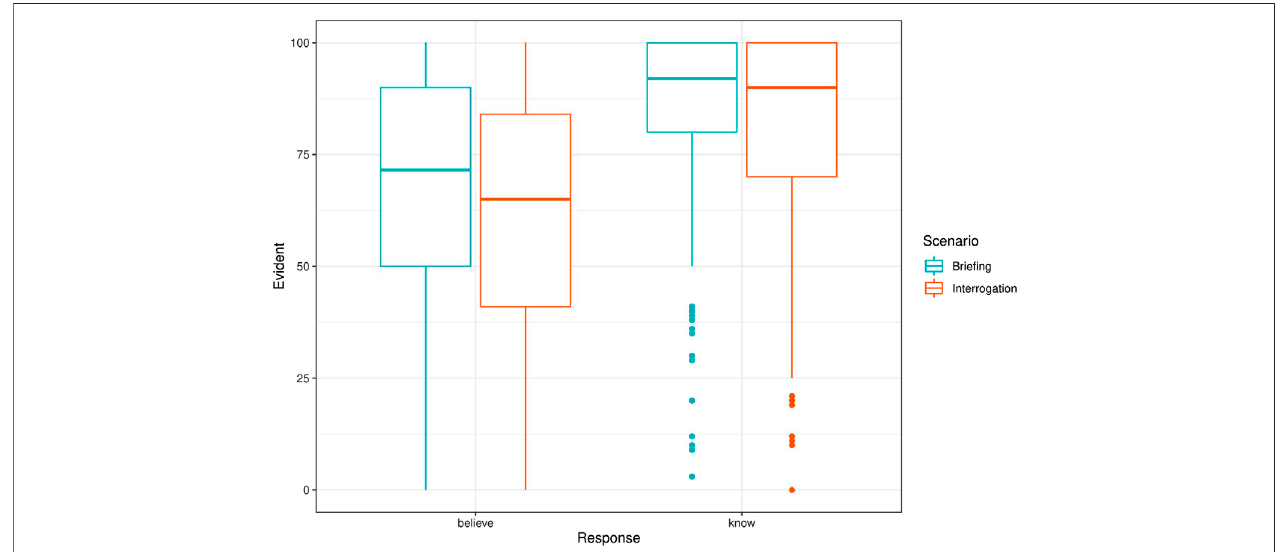
FIGURE 2 | By-expression evidentiality ratings for each scenario (brie fi ng in blue, interrogation in red). The plot shows the median of the evidentiality ratings (line) and the upper quartile and lower quartile (box). Whiskers extend to the scores outside the quartiles. Dots represent outliers.